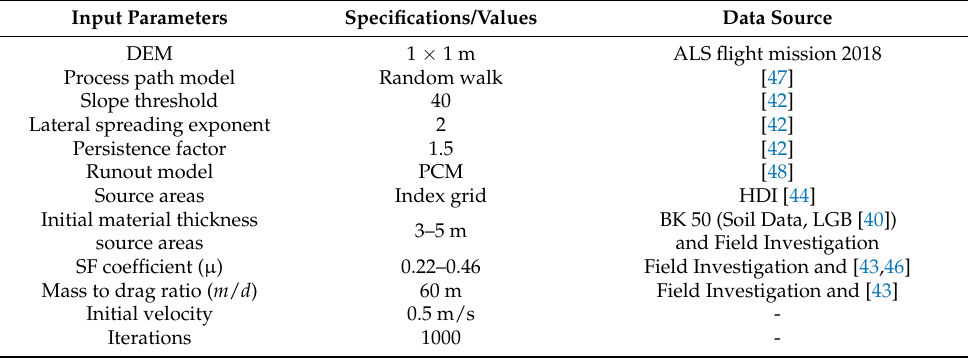
Table 2. Crucial model input parameters used in